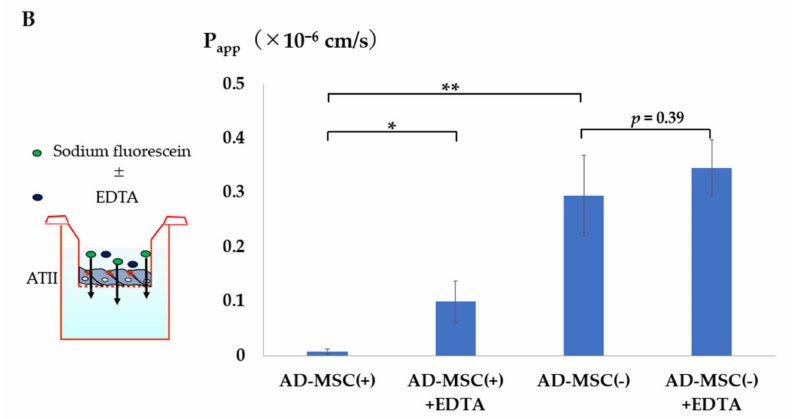
Figure 5. Permeability assay. ( A ) Transport of sodium fluorescein across the lung cell monolayer after 4 days of cultivation with (+) or without ( − ) non-contact AD-MSCs. ( B ) Transport of sodium fluorescein across the ATII cell monolayer after 7 days of cultivation with (+) or without ( − ) non- contact AD-MSCs. All data represent means ± standard deviations; * p < 0.05, ** p < 0.01, *** p < 0.001.